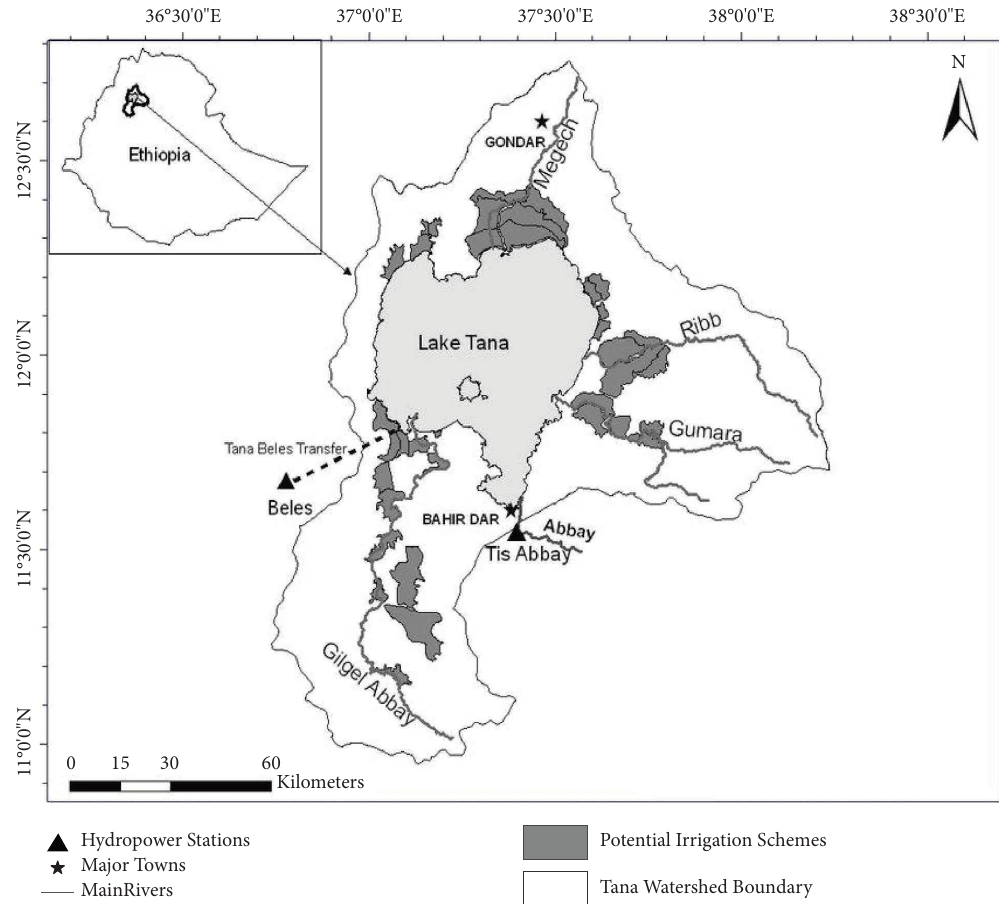
Figure 1: Te location map of Bahir Dar town, Northwest Ethiopia. Table 1: Vegetables commonly used in Bahir Dar town, Northwest